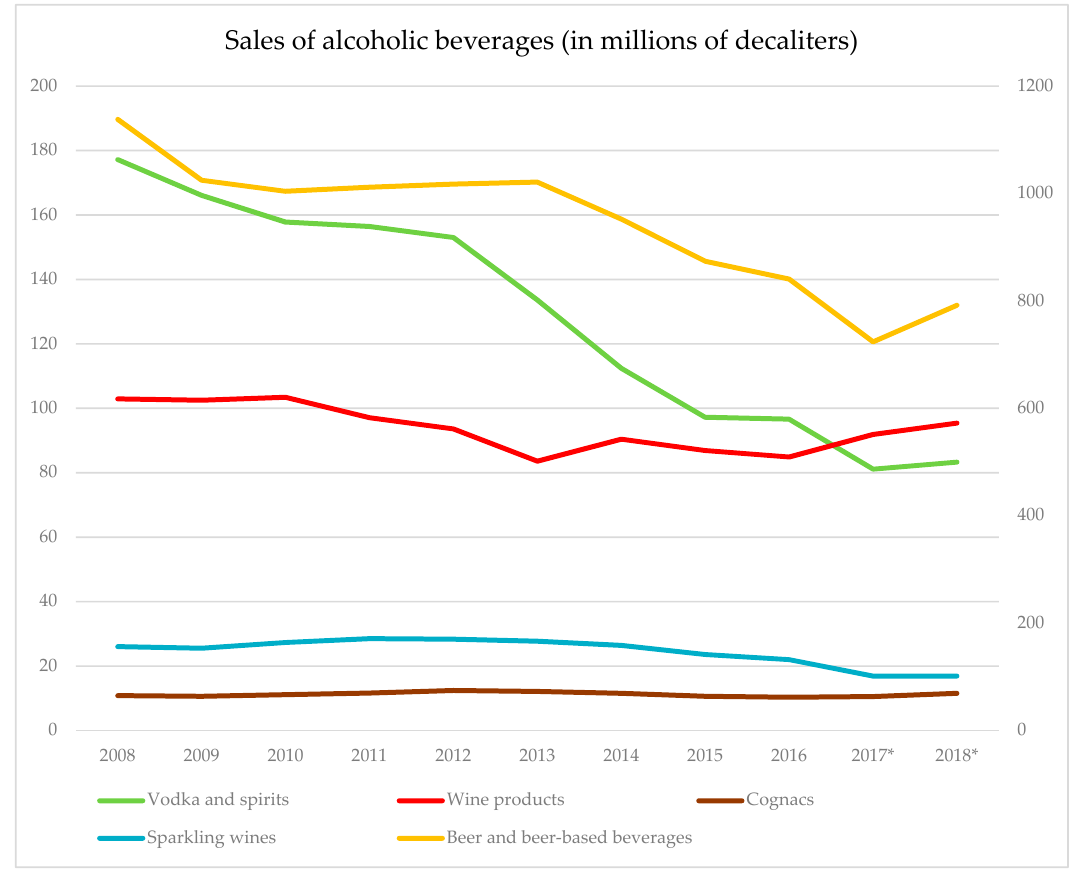
Figure 4. Sales of alcoholic beverages in millions of deciliters. Left scale: vodka and spirits, wine and wine products, sparkling wines. Right scale: beer and beer-based products. Sources: Federal State Statistics Services, beginning in 2017, Federal Service for Alcohol Market Regulation as based on the EGAIS* monitoring.